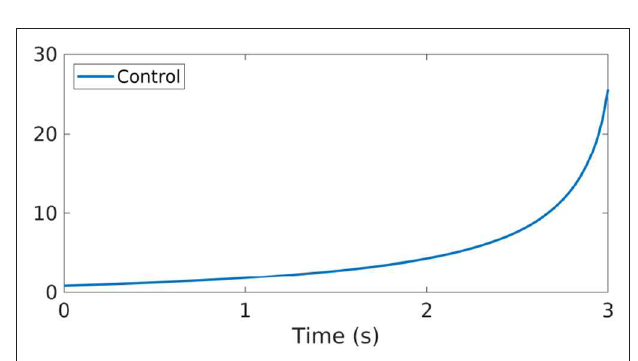
FIGURE 9 | Evolution of the uncontrolled (left) and controlled (right) dynamics of the Kuramoto model [Equation (22)] with N interactions as in Figure 8 .